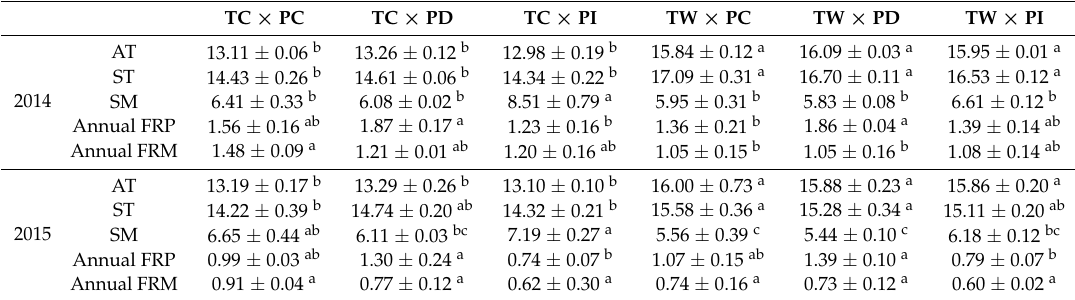
Table 2. Air temperature (AT, ° C), soil temperature (ST, ° C), soil moisture (SM, vol %), annual fine root length production (FRP, mm cm − 2 year − 1 ), and annual fine root length mortality (FRM, mm cm − 2